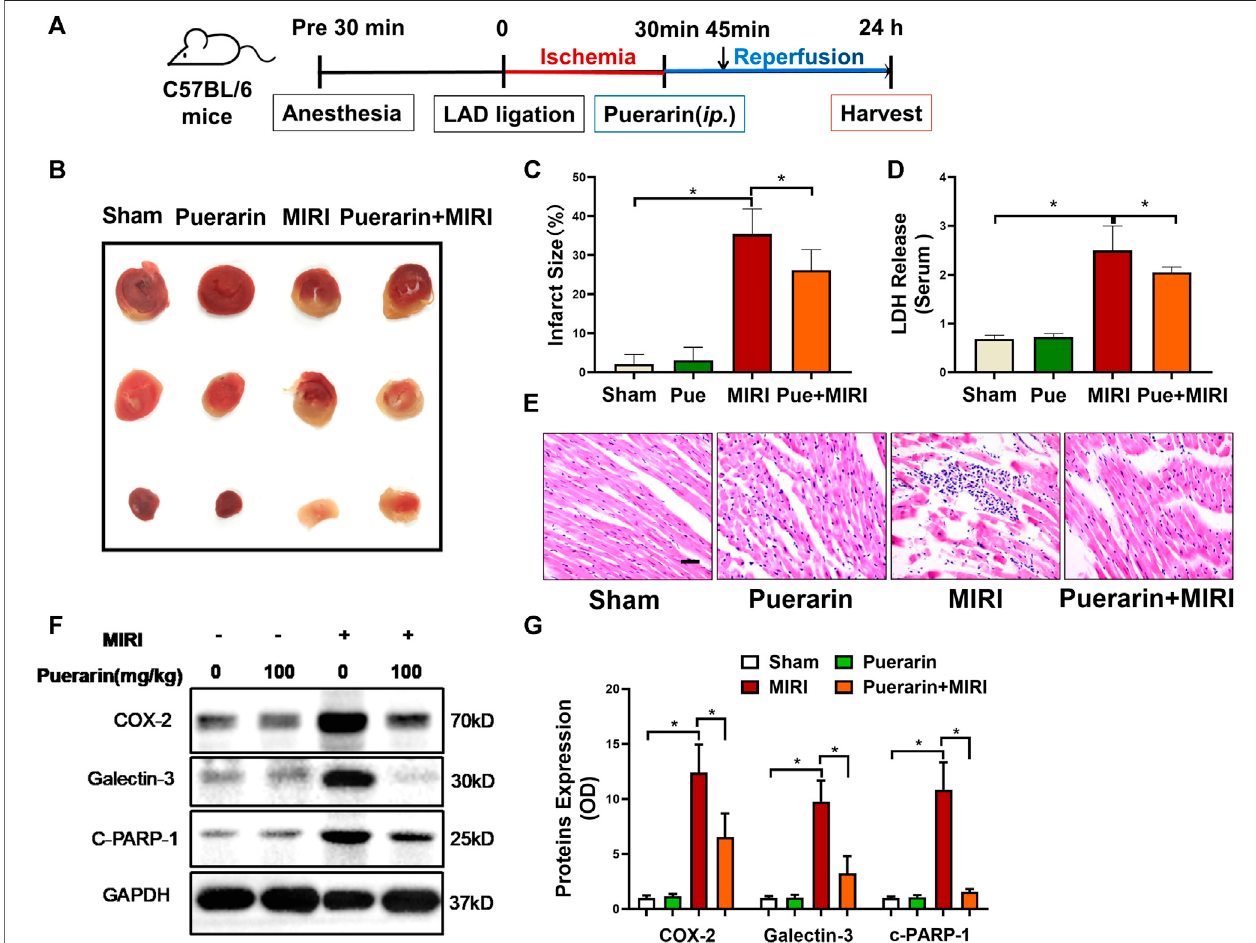
FIGURE 1 | In vivo cardioprotective activity and anti-in fl ammatory effects of puerarin in mouse MI-RI model. (A) Outline of experimental design. C57BL/6N mice were subjected to LAD ligation to induce the MI-RI model. After 45 min of ischemia and 24 h of reperfusion, the hearts were harvested for further analysis. Puerarin 100 mg/kg was intraperitoneally injected 15 min before reperfusion. (B) Detection of myocardial infarction. After the tissue was stained in 2% TTC for 15 min, the infarct area (IA %) was assessed. (C) Quantitative analysis of infarct size. (D) Determination of serum LDH levels. The serum was collected from mice and determined for LDHlevels. (E) H&Estainingofmyocardialtissue.CardiactissueswerestainedwithH&Estainingandimagedunderlightmicroscopy.Scalebar:50 μ m. (F) Westernblot analysis of biomarkers. Cardiac tissues were collected and analyzed by Western blotting with antibodies against COX2, galectin-3, cleaved-PARP-1. (G) Quanti fi cation of COX2, galectin-3 and cleaved-PARP-1 expression. The results were shown as mean ± SD ( n (cid:2) 6). * p < 0.05.